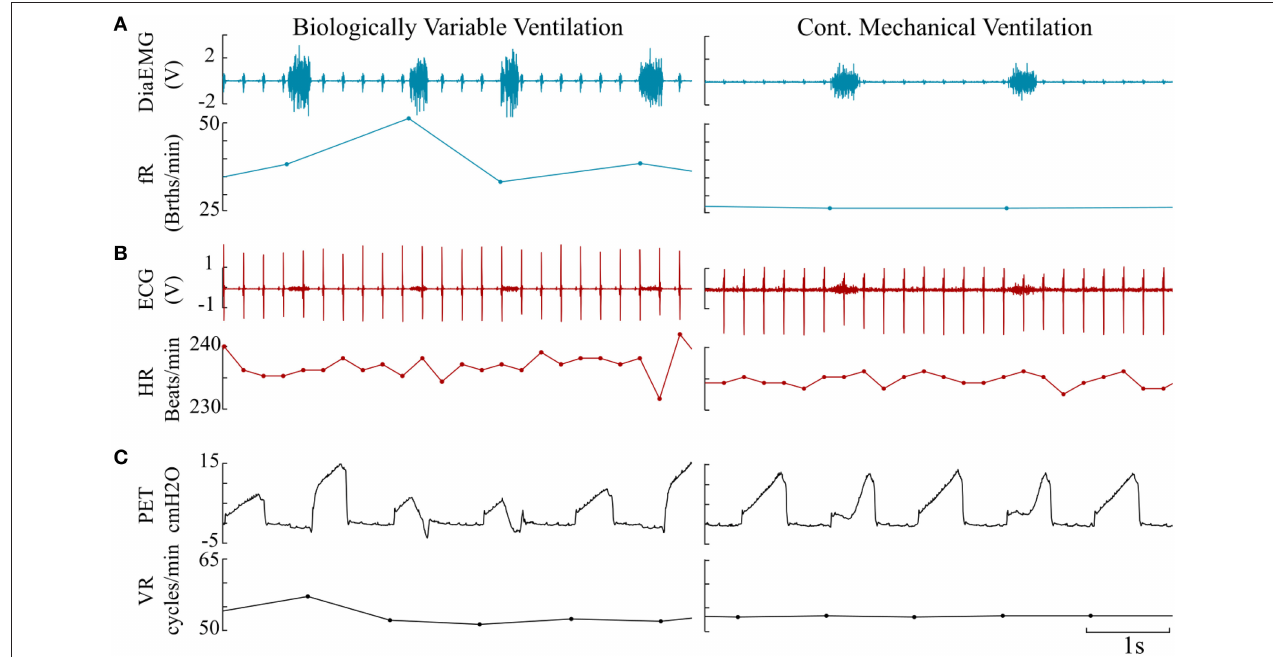
FIGURE 2 | Representative paired traces consisting of raw data and derived instantaneous rates measured from BVV and CMV rats. (A) Diaphragm electromyogram (DiaEMG, Volt) paired with instantaneous respiratory frequency (fR, Breaths/minute). (B) Electrocardiogram (ECG) & heart rate (HR, Beats/minute). (C) Endotracheal pressure (PET, cm H2O) & ventilator rate (VR,